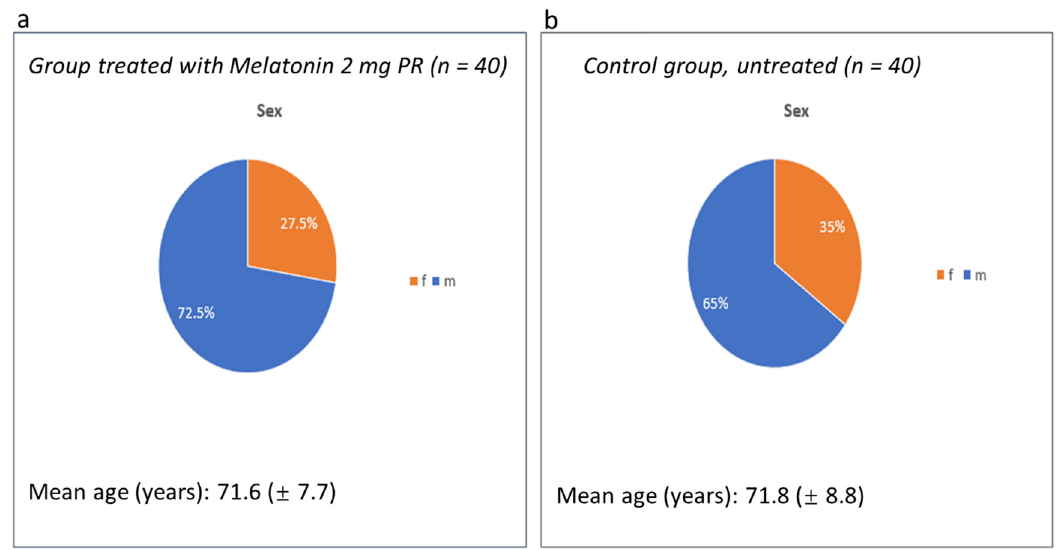
Figure 1. ( a ): 40 patients (23 males and 17 females, with a mean age of 71.6 years) in the group treated with PRM 2 mg. ( b ): 40 patients in the control group (we considered 40 patients, 23 males and 17 females, with a mean age of 71.8 years).